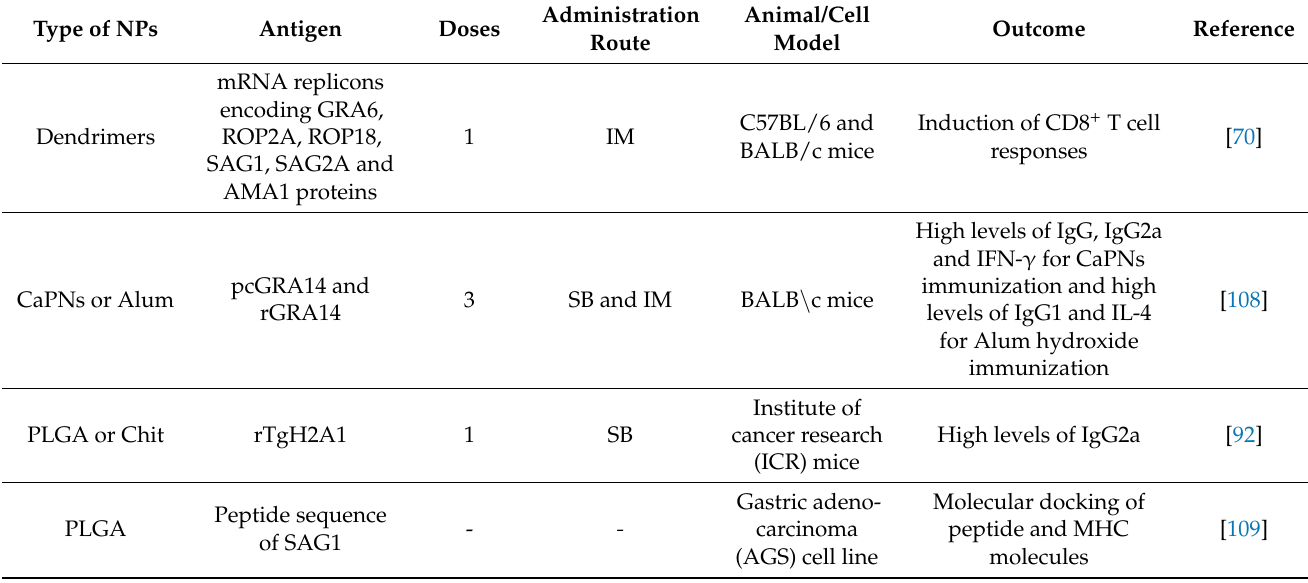
Table 2. Recent studies carried out using NPs for the development of vaccines against T. gondii